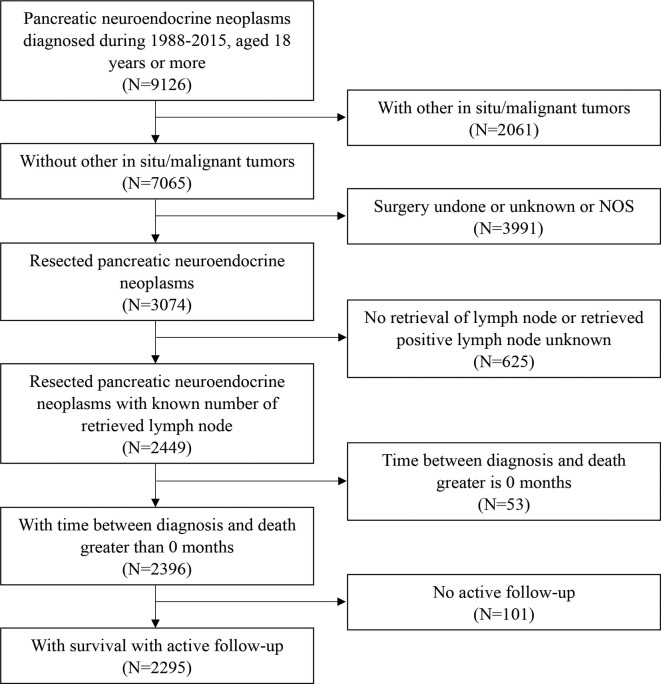
Flow diagram of patient selection.